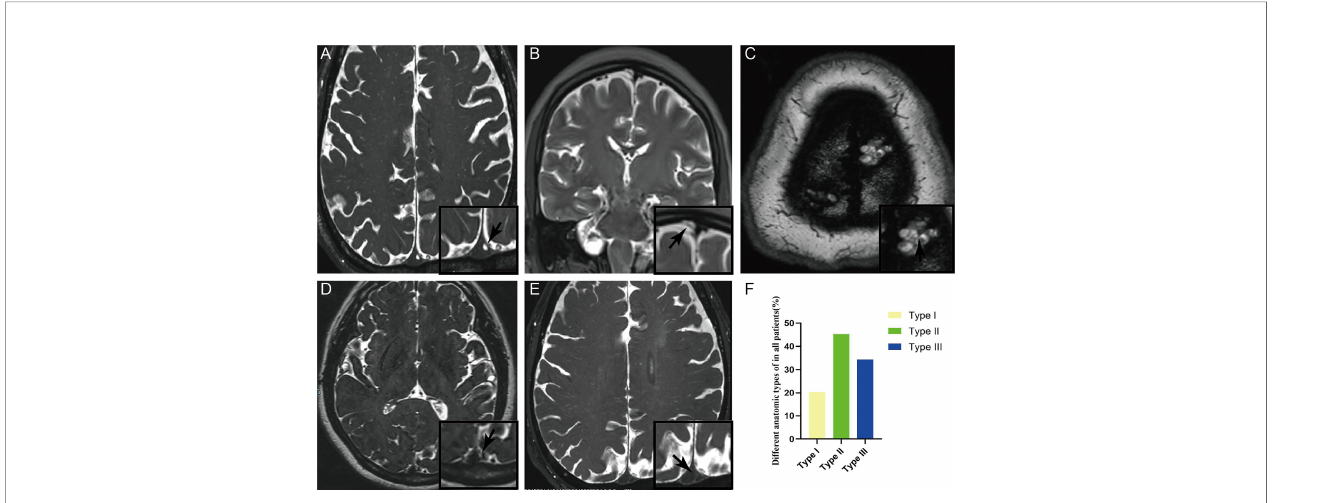
FIGURE 3 | Three types of arachnoid granulation in the superior sagittal sinus were delineated from normal cerebral tissues with hyper-intensity on T2WI. CWs were also present in the lumen of superior sagittal sinus. Arachnoid granulation in the lumen (A) , lateral sinus (B) , and subarachnoid space (C) . Both longitudinal lamellae (D) and trabeculae (E) in the lumen of superior sagittal sinus. Graphs showing comparisons of the number of type I, type II and type III in the superior sagittal sinus (F)